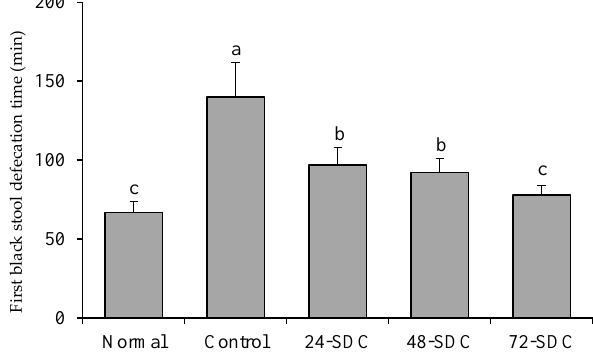
Figure 4. First black stool defecation time of mice after diphenoxylate treatment. Values presented are means ± standard deviation ( n = 5). Different letters indicate significant differences ( p < 0.05) between each group, and the same letters indicate that there is no significant difference ( p > 0.05) between each group according to Tukey’s test for multiple comparisons. 24-SDC: 24-h-fermented Shuidouchi; 48-